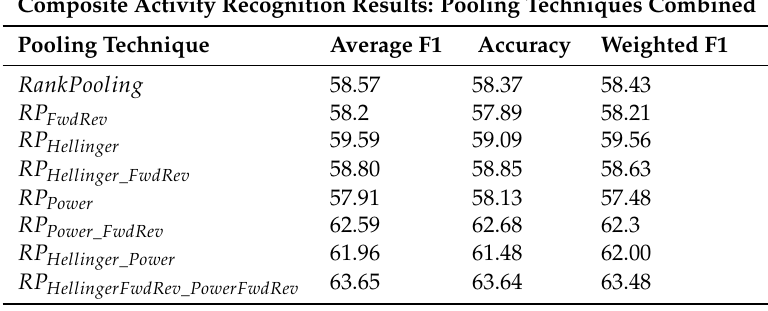
Table 6. Results of rank pooling fused with max and average pooling: leave-one-subject-out cross